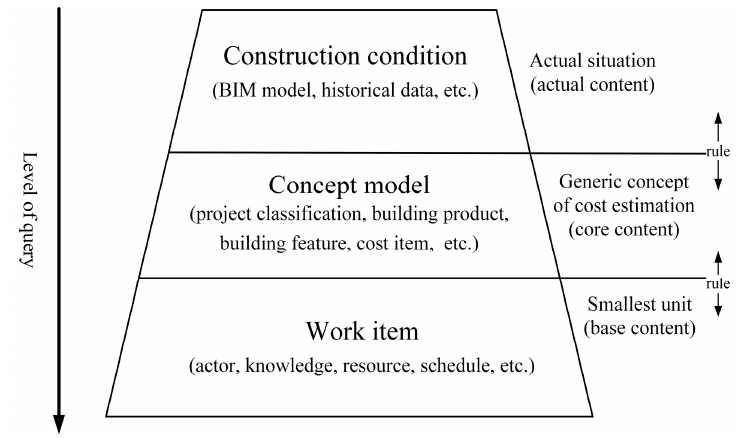
Figure 1. Steps for ontology representation model interpretation.